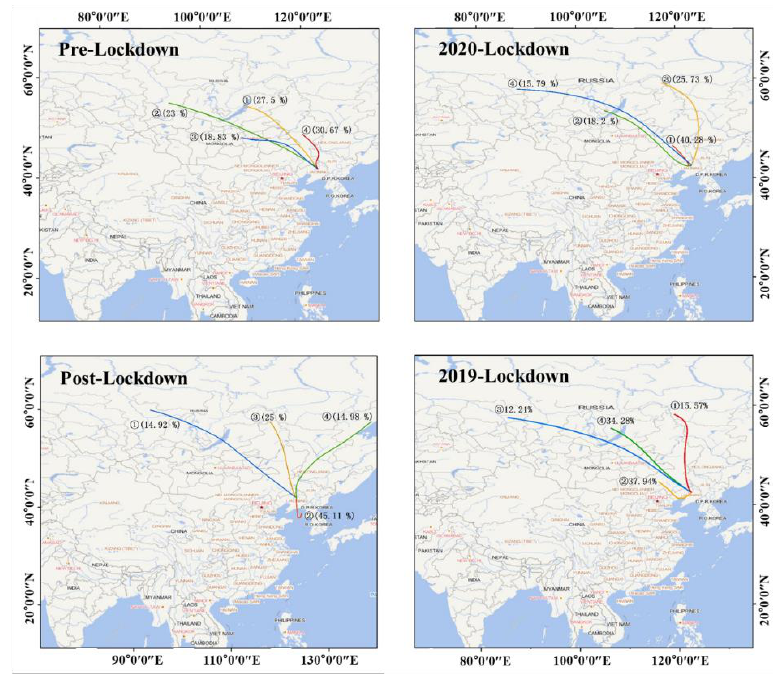
Figure 13. The backward trajectory clustering paths during the preset research periods.